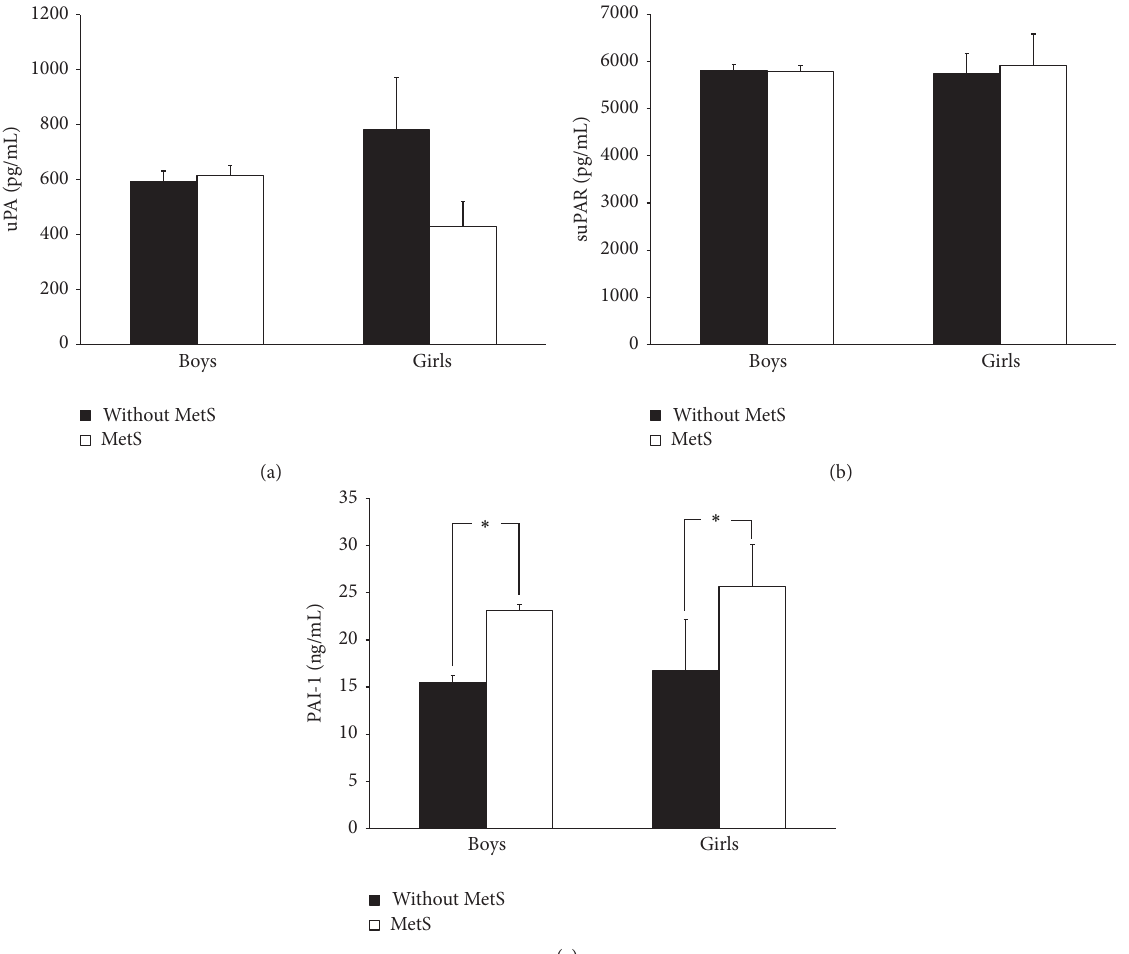
Figure 2: (a) Urokinase plasminogen activator (uPA), (b) soluble urokinase plasminogen activator receptor (suPAR), and (c) plasminogen activatorinhibitor-1(PAI-1)inchildrenwithandwithoutmetabolicsyndrome(MetS).TheuPAandsuPARlevelsarenotsignificantlydifferent between children with and without MetS. However, children with MetS have higher PAI-1 levels. Mean ± SE; ∗ 𝑃 < 0.05